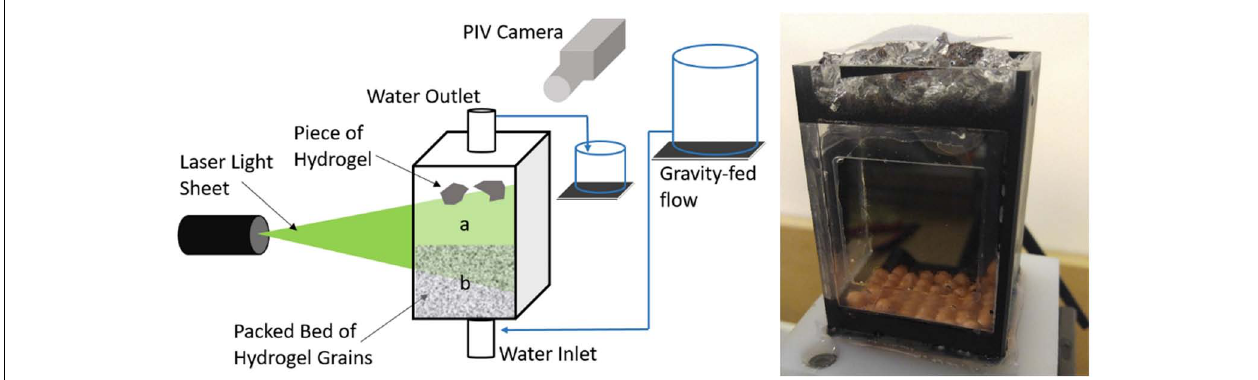
FIGURE 1 | Flow cell schematic (on the left) operated in two modes: mode “a” with pieces of hydrogel, and mode “b” with a packed bed of hydrogel. Note that each mode was tested separately with only one mode being in the test cell at a time. The flow cell is 5 cm by 5 cm footprint and 7 cm high. Photograph of the flow cell (on the right) with the lid removed and filled with hydrogel grains and water. Additional hydrogel grains were added on the top and are in air. Those in the air are visible but those fully submerged are invisible in water as their refractive index matches that of the water.